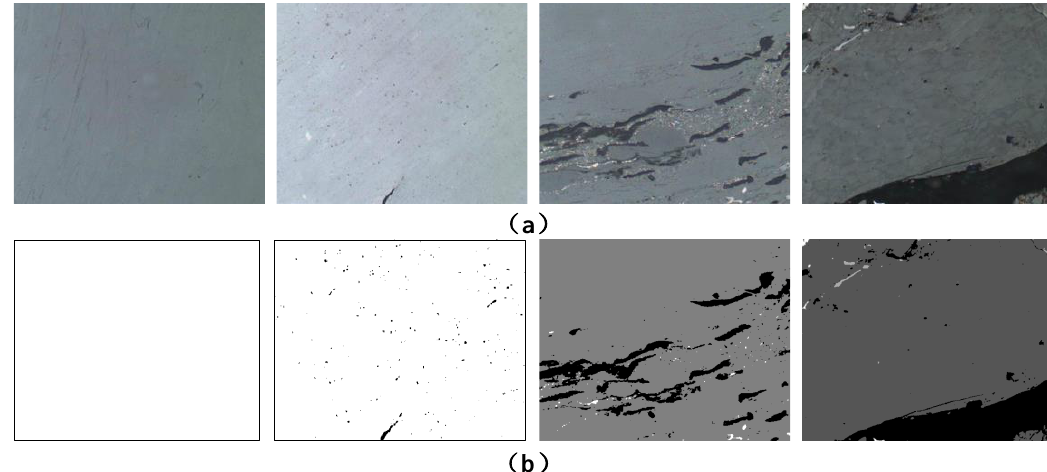
Figure 5. The results of adaptive K-means clustering (the first row consists of four original photomicrographs and the second row consists of the segmentation results of the corresponding photomicrographs in the first row. From left to right, the number of clusters is 1, 2, 3, and 4, respectively). ( a ) Original photomicrographs; ( b ) Segmentation results of each corresponding photomicrograph in the first row.